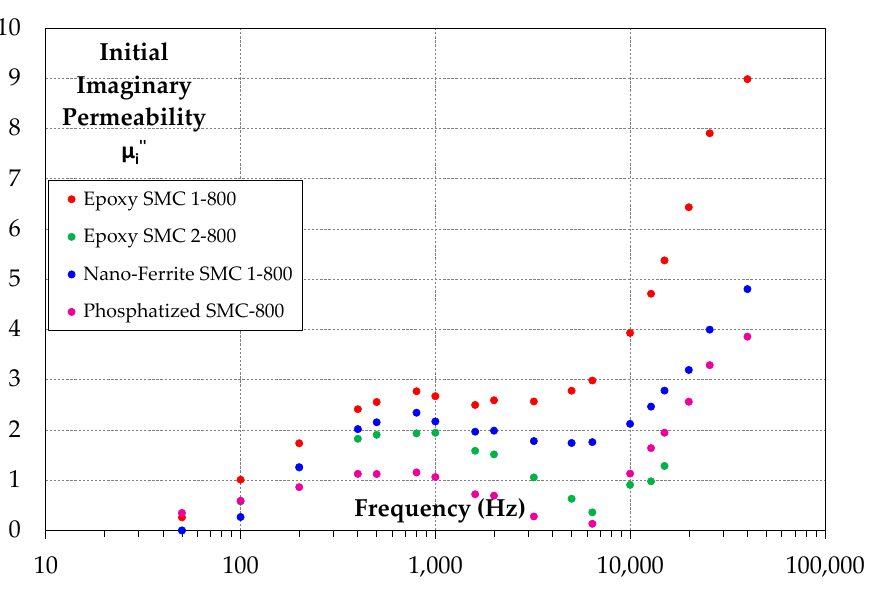
Figure 9. The real part of the initial magnetic permeability of proposed toroid samples in a frequency range of 40 kHz.